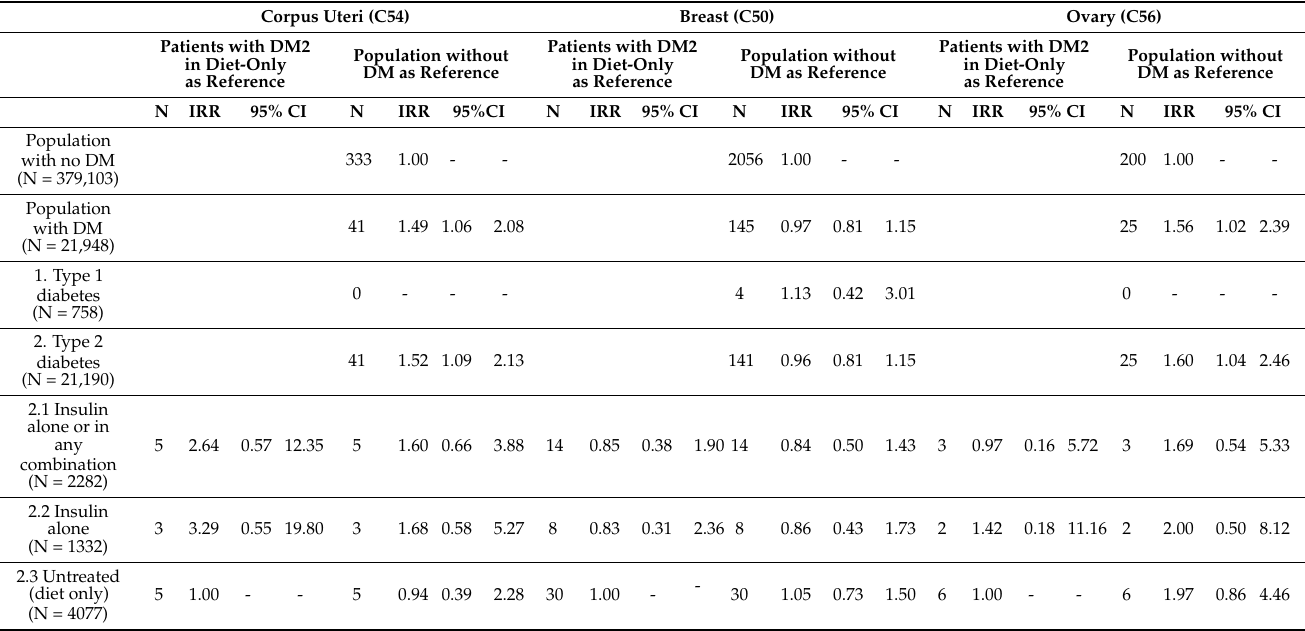
Table 5. Number, incidence rates ratios (IRR), and 95% confidence intervals (95% CI) of colorectal, pancreatic, liver, trachea, bronchus, and lung cancer, stomach cancer and lymphoma, corpus uteri, breast (women only), ovary, kidney, bladder, and prostate cancer by type of treatment with type 1 and type 2 diabetes (DM1; DM20). Reggio Emilia 2011-16, resident population aged 20–84 years. See Supplementary Material Table S6 for “other sites”.